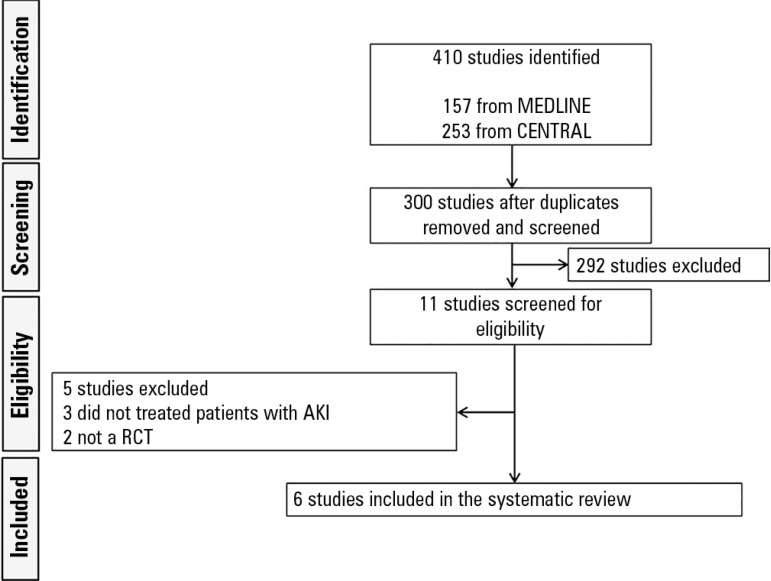
Flowchart of the study's search and selection process.AKI - acute kidney injury; RCT - randomized controlled trial.